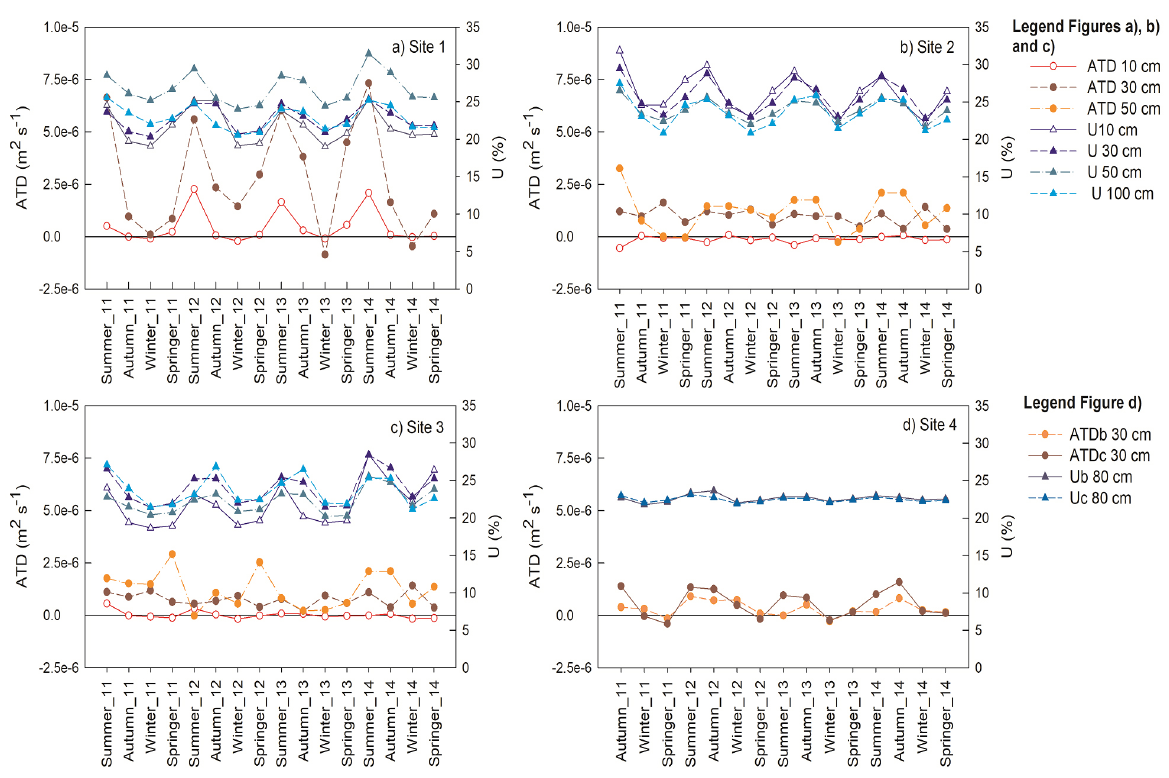
Figure 2. Relationship between apparent seasonal thermal diffusivity of soil and seasonal soil moisture in the Keller Peninsula, Maritime Antarctica. *ATD 10 = apparent thermal diffusivity at 5, 10 and 30 cm depth and ATD 30 = apparent thermal diffusivity at 10, 30 and 100 cm depth (site 1); ATD 10 = apparent thermal diffusivity at 5, 10 and 30 cm depth 5, 10 and 30 cm depth; ATD 30 = apparent thermal diffusivity at 10, 30 and 50 cm depth and ATD 50 = apparent thermal diffusivity at 30, 50 and 100 cm depth (sites 2 and 3). ATD = apparent thermal diffusivity at 10, 30 and 80 cm TC/TB_30 depth at the polygon border (TB) and center (TC). U = Soil moisture at 10, 30, 50, 80 and 100 cm depth. Uc = Soil moisture (%) at polygon center; Ub = Soil moisture (%) at polygon